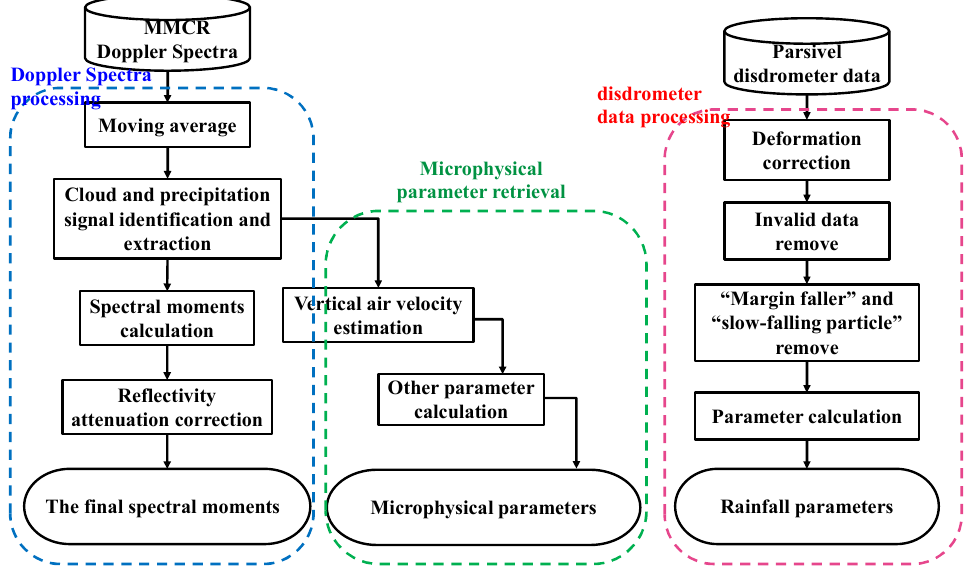
Figure 1. The flow chart of data processing and microphysical parameter retrieval for MMCR and Parsivel disdrometer.